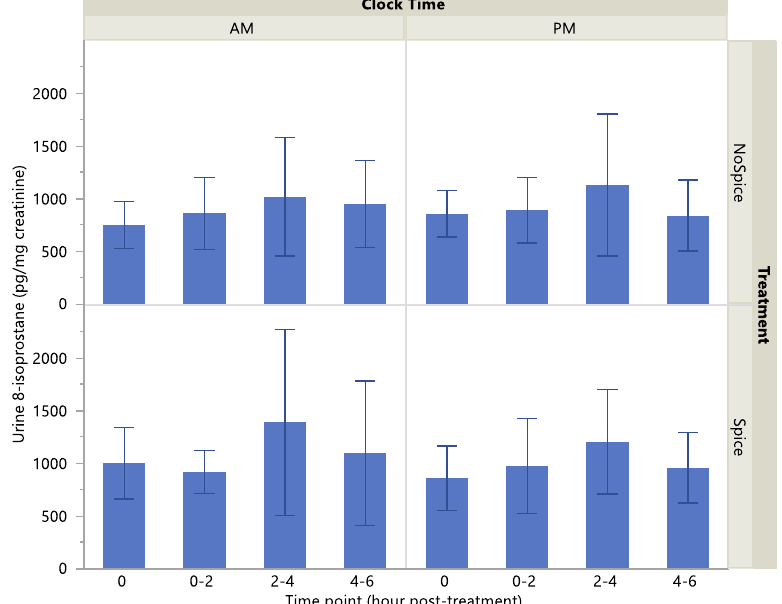
Figure 1. Urine 8-isoprostane concentrations by treatment, clock time and time point. Values are means with standard deviation. Effect of treatment, p = 0.02; clock time, p > 0.05; time point, p = 0.03.